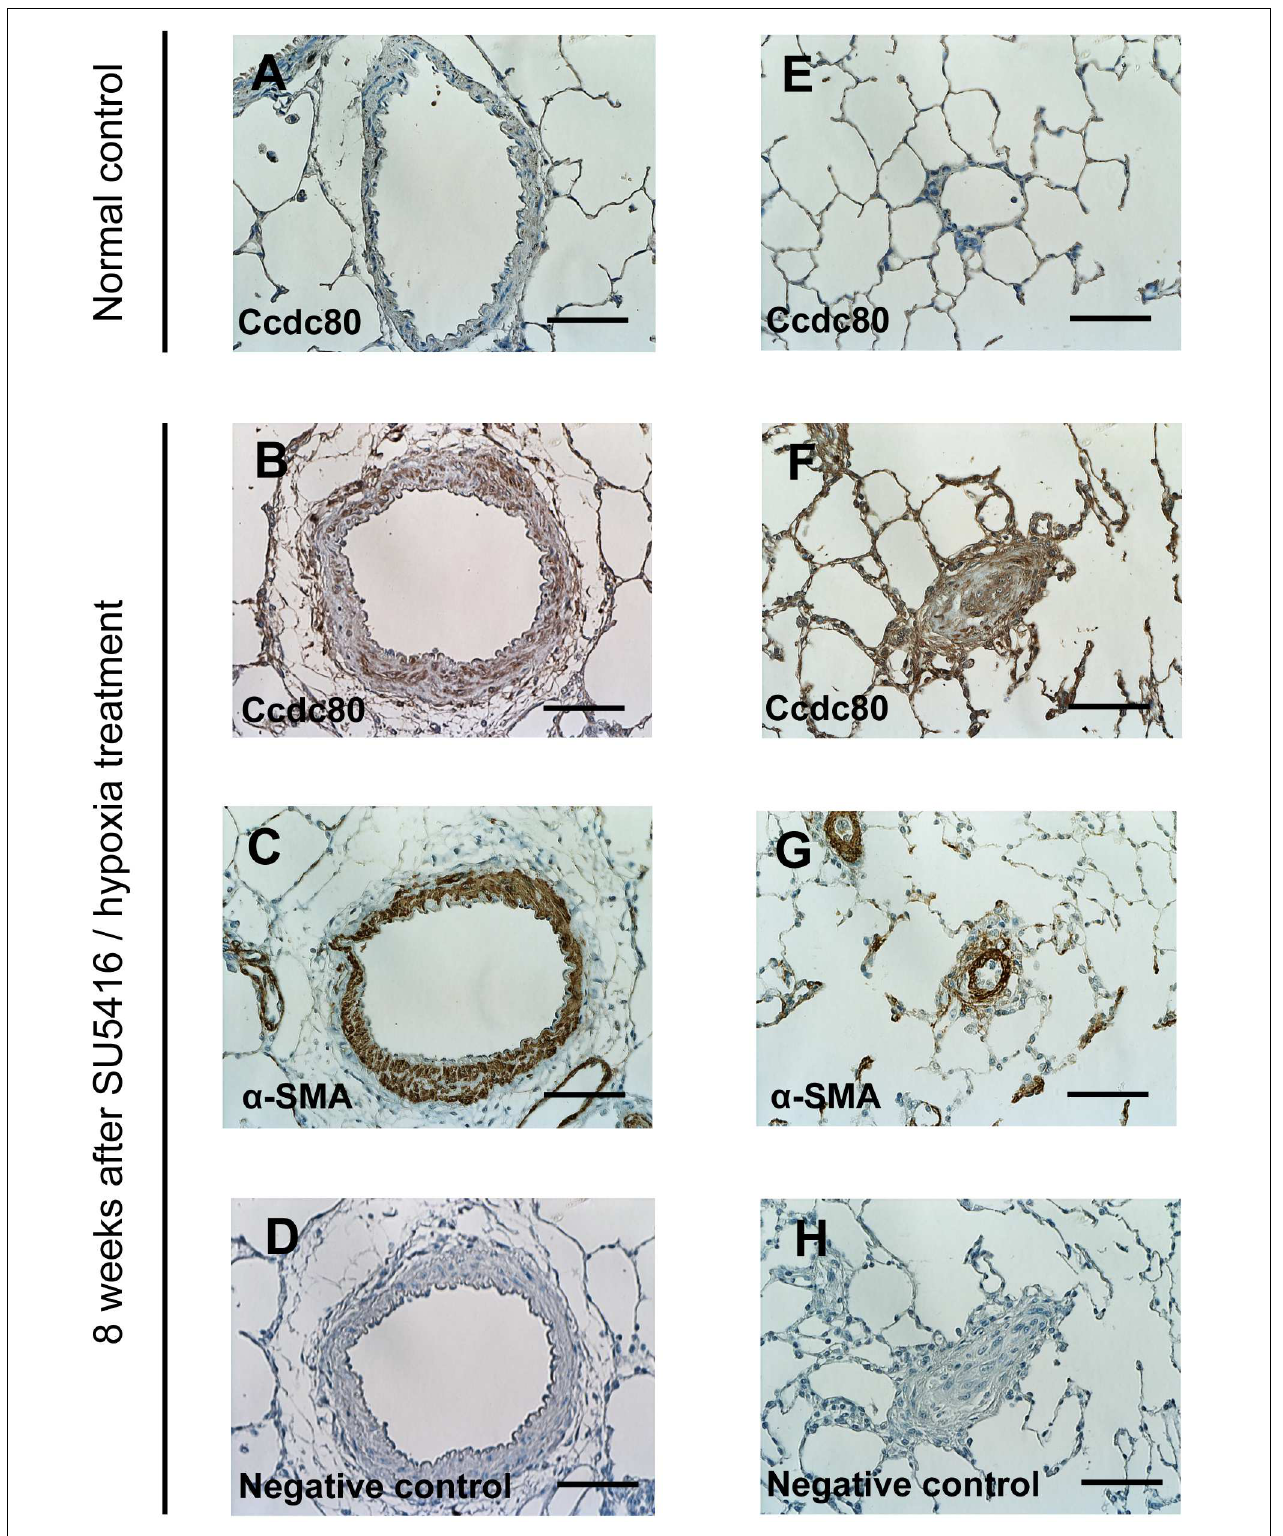
FIGURE 5 | Expression of Ccdc80 is increased in the lungs of rats with PAH. (A–H) Representative photomicrographs of pulmonary arteries (PAs) from control rats (A and E) or rats with PAH induced by SU5416 /hypoxia (B–D and F–H) . Serial cross-sectional views of pre-acinar PA (A–D) and intra-acinar PA (E–H) immunostained for Ccdc80 and α -smooth muscle actin ( α -SMA). Scale bars, 50 µ m. Original magnification ( × 400).